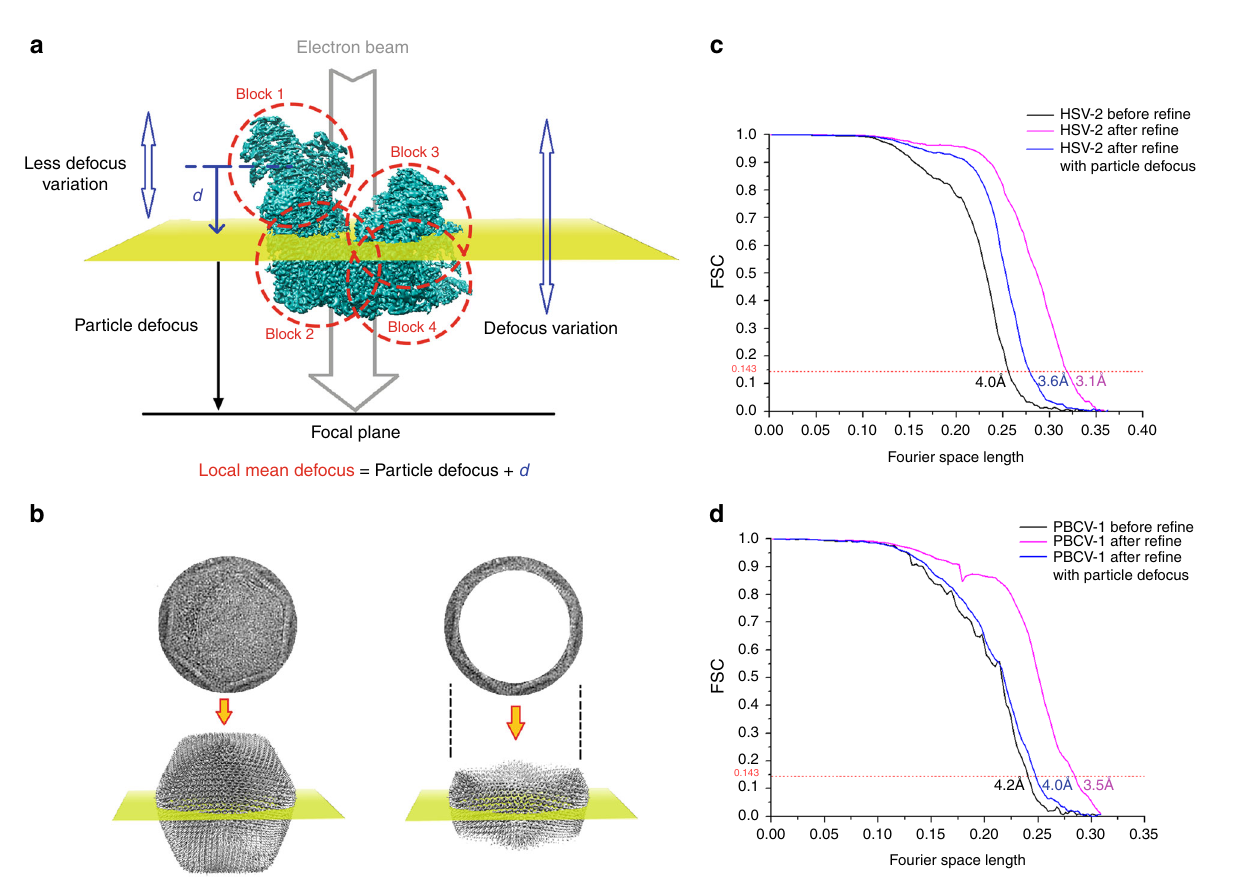
Fig. 2 The block-based reconstruction, particle defocus, and local mean defoci of blocks. a To show how block-based reconstruction works, a density map (EMD-6775) was divided into four blocks, which are circled with red dashes. The distance between the center of mass of the model and the focal plane of objective lens along the Z axis is the particle defocus. Each block has its own local mean focus, which is the sum of the particle defocus values with the distance from the center of the block to the center of the model along the Z axis. b The Thon rings calculated from the whole virus (left) or after excluding the central part (right). The region of the virus in the 2D image (up right) corresponds to the part of the virus that is near the particle defocus plane in the 3D virus (down right). c The resolutions determined by gold standard FSC at threshold 0.143 of HSV-2 capsid reconstructions by a conventional reconstruction method (colored in black), by block-based reconstruction with local re fi nement of translational and rotational parameters of each block but without applying local mean defocus (colored in blue), and by block-based reconstruction with local re fi nement and local mean defocus being applied to overcome the Ewald sphere effect (colored in red). d The resolutions determined by gold standard FSC at threshold 0.143 of PBCV-1 virus reconstructions by a conventional reconstruction method (colored in black), by block-based reconstruction with local re fi nement of translational and rotational parameters of each block but without applying local mean defocus (colored in blue), and by block-based reconstruction with local re fi nement and local mean defocus being applied to overcome Ewald sphere effect (colored in